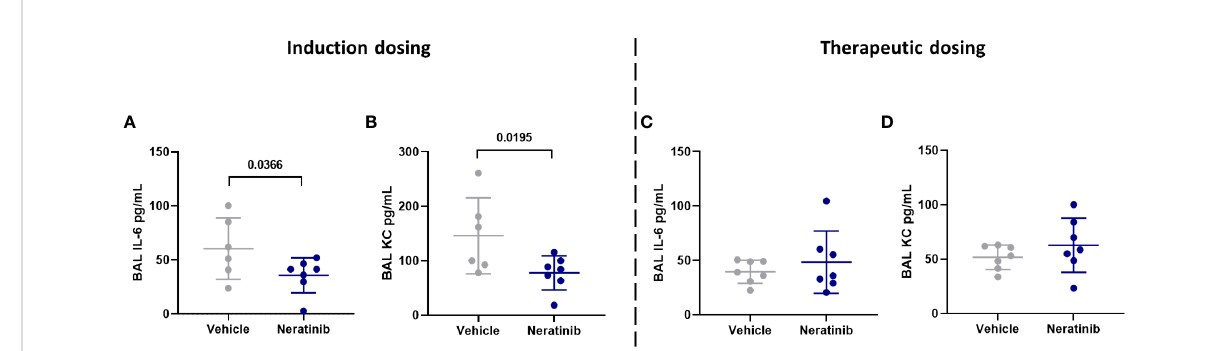
FIGURE 7 Neratinib treatment reduces the levels of cytokines IL-6 and KC in BAL in the induction dosing model of lung disease. Cytokines were measured in BAL supernatant by ELISA. Interleukin-6 (IL-6) and KC were reduced in neratinib-treated mice in the induction dosing model (A, B) , whereas these were unchanged in the therapeutic dosing model (C, D) . Each data point represents data from one mouse; bars show mean ± standard deviation. Unpaired t -tests were used for statistical analysis; p -values were